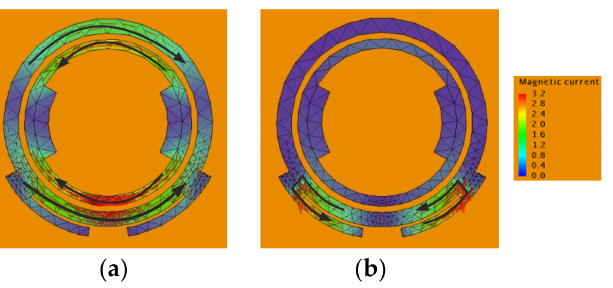
Figure 9. Simulated magnetic current distribution of the proposed antenna at different frequencies. ( a ) 2.08 GHz ( b ) 3.23